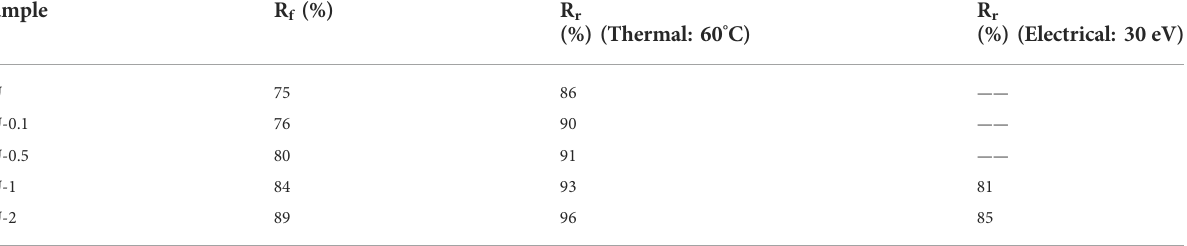
TABLE 3 Shape memory properties of SMPU and SMPU/i-MWCNT composites with various i-MWCNT contents.